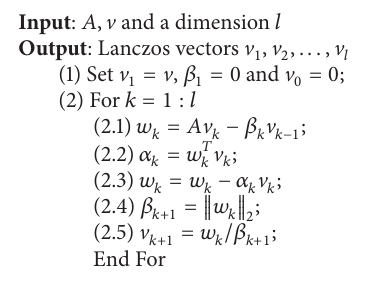
Algorithm 4: Lanczos